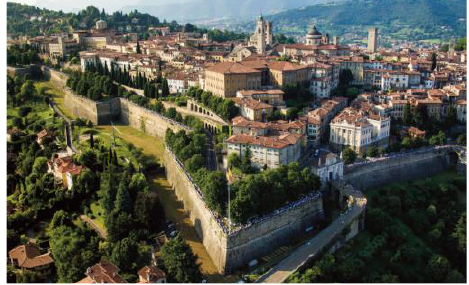
Figure 2. View of Bergamo “Città Alta” (source: Comune di Bergamo).